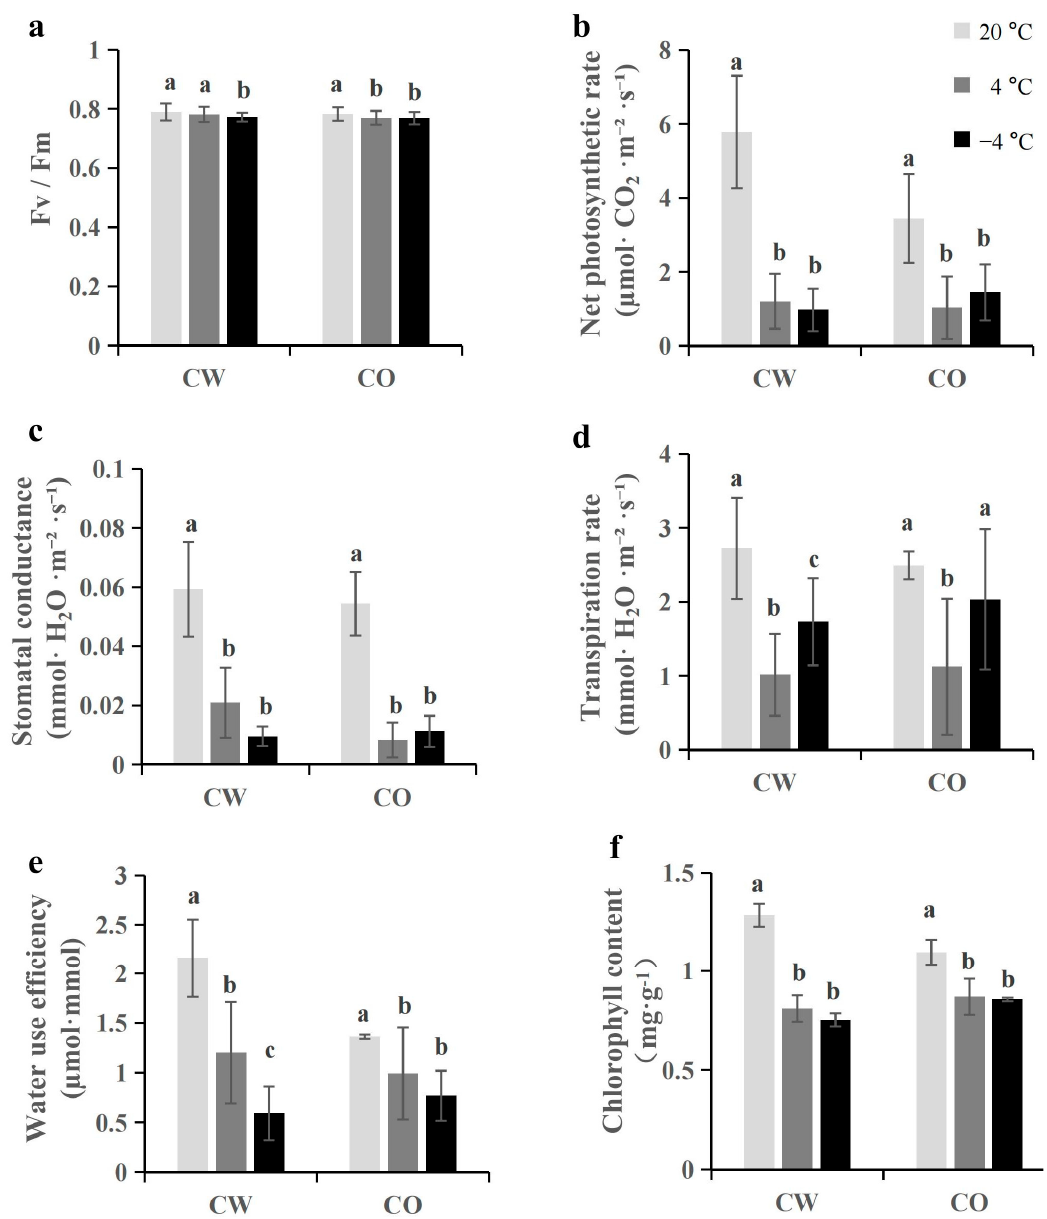
Figure 2. Effects of cold stress on photosynthesis in two Camellia species. ( a ) F v /F m , ( b ) net photosynthetic rate, ( c ) stomatal conductance, ( d ) transpiration rate, ( e ) water use efficiency, ( f ) chlorophyll content. CW, Camellia weiningensis ; CO, Camellia oleifera. CW and CO seedlings were exposed to 20 ◦ C, 4 ◦ C (chilling stress) and − 4 ◦ C (freezing temperature) for 24 h, then photosynthetic parameters were measured after 1 d recovery from cold stress. Nine plants per treatment were used as one replicate, four leaves per plant were used for measurements, and the experiment was set up for three repetitions. Values (means ± SE) followed by different letters in each species indicate significant differences among treatments ( p < 0.05).